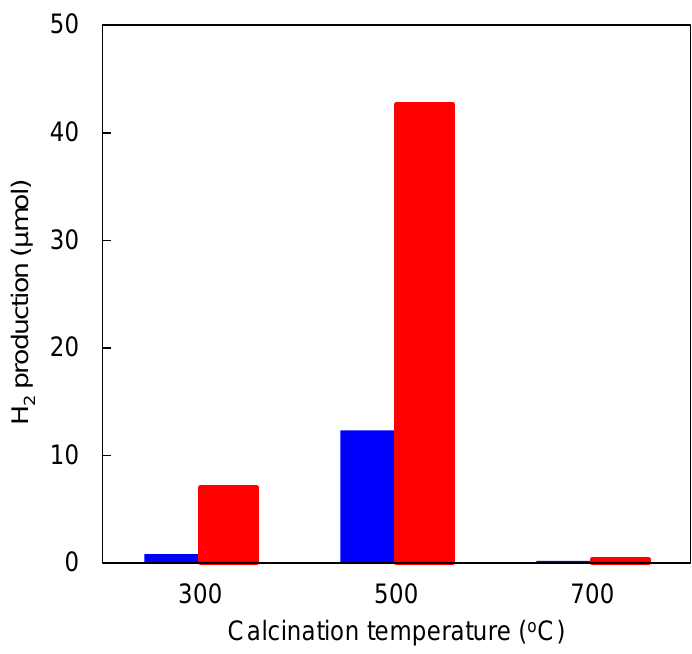
Figure 5. Effect of calcination temperature on photocatalytic H 2 production from formic acid with TiO 2 nanotubes with the aid of simultaneous Rh deposition. Reaction time: 3 h (blue bar) and 5 h (red bar); reaction temperature: 50 °C; calcination time: 2 h.